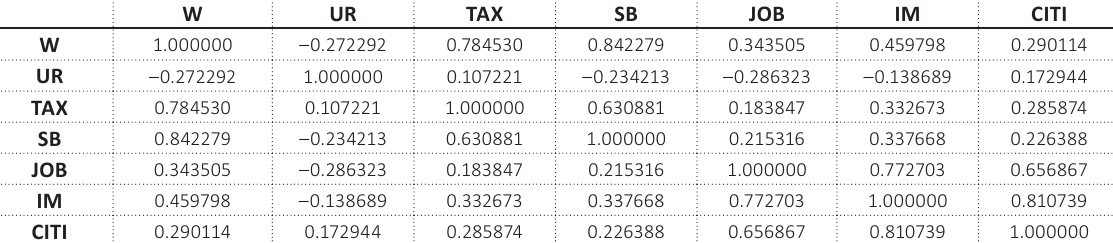
Table 2. Correlation matrix (EViews screen result) for the dependence between the immigrants in the EU from Ukraine (IM) and the set of the external factors